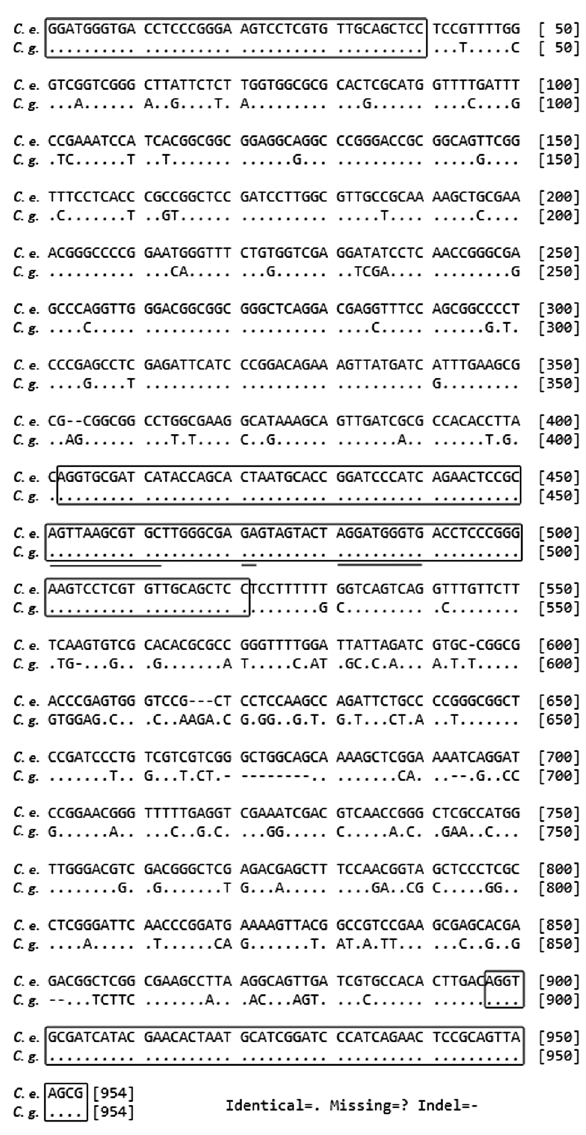
Figure 1. Alignment of the major fragments amplified from the 5S rDNA repeats of Canavalia gladiata (C. g.) and Canavalia ensiformis (C. e.). The entire 120-bp 5S rRNA gene and the 40 and 58 bp of the gene flanking the 5' and 3' ends are enclosed in a box; the intragenic promoter motifs are underlined. the fragments. The minor fragments (459 bp and 457 bp amplified from C. gladiata and C. ensiformis , respectively) included the entire 361 bp NTS (in C. gladiata ) or 359 bp NTS (in C. ensiformis ). The major fragments (940 bp and 948 bp amplified from C. gladiata and C. ensiformis , respectively) consisted of two NTS regions separated by the whole gene sequence. The major fragments were deposited in the